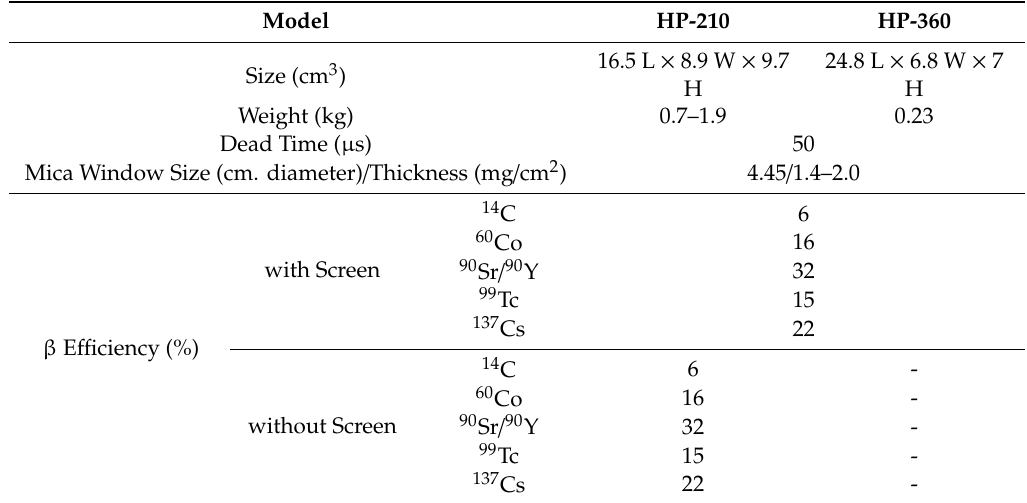
Table 10. Specifications of HP-210/HP-360 series pancake Geiger–Mueller detectors.